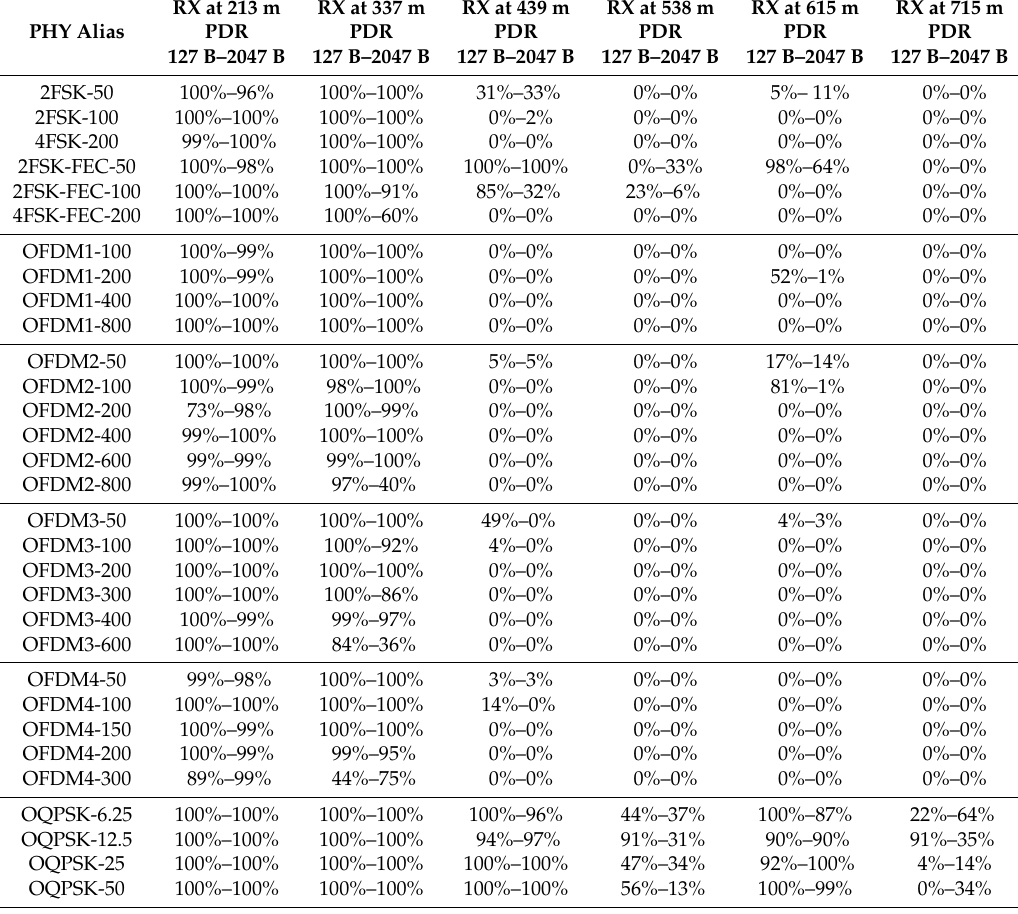
Table 8. Smart Agriculture. PDR for packets of 127 B and 2047 B for each RX node. Maximum coverage with high data rate happens at 337 m and maximum length of the radio link with useful PDR and data rate of at least 50 kbps is at 615